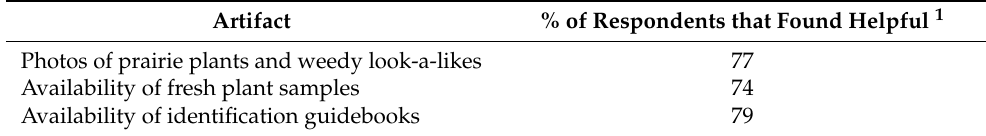
Figure 5. Retrospective self-report on ability to assess age of a prairie strips planting (N = 39). Legend indicates Likert-style response scale. This is the confidence or self-efficacy-oriented scale. Table 2. Prairie plant identification